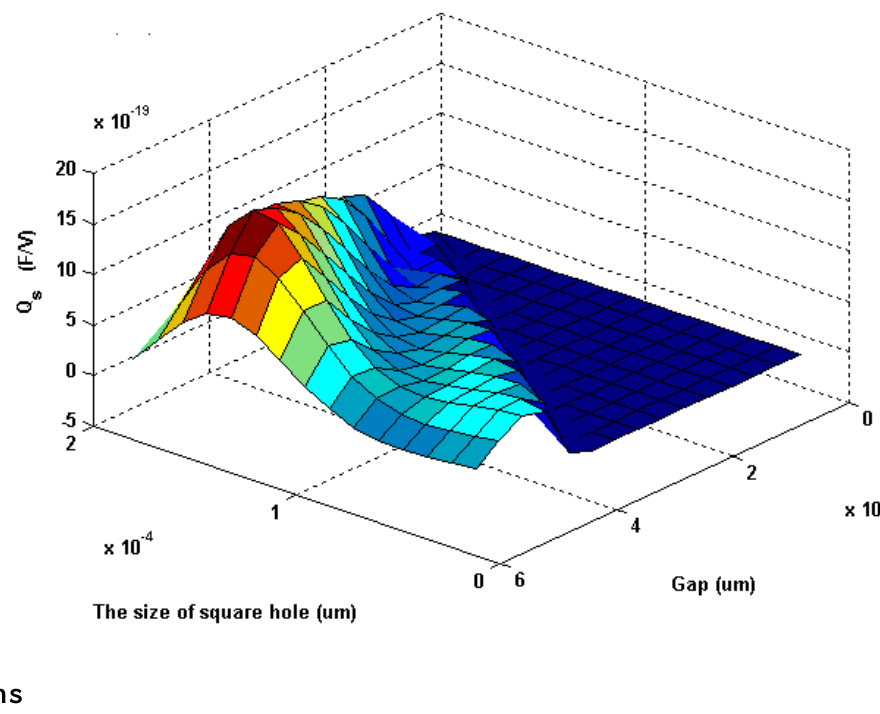
Figure 21. Effect of the hole size and gap on sensitivity for 200 μ m × 200 μ m × 3 μ m plate, with V = 10 V, P = 101,000 Pa, k = 51.65 N/m, Δ m / m o a flex